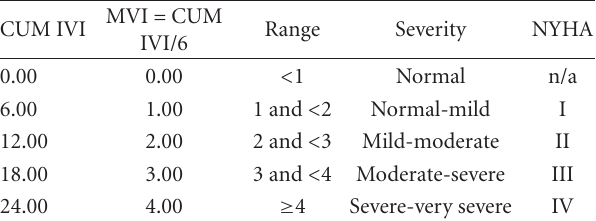
Table 3: MVI scoring system weighted for P CAP . MVI = CUM CUM IVI Range IVI/7 0.00